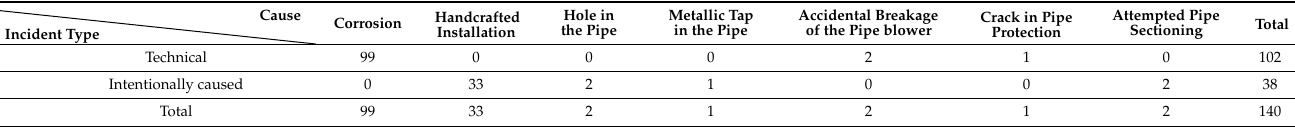
Table 14. The crosstab for incident type and cause.